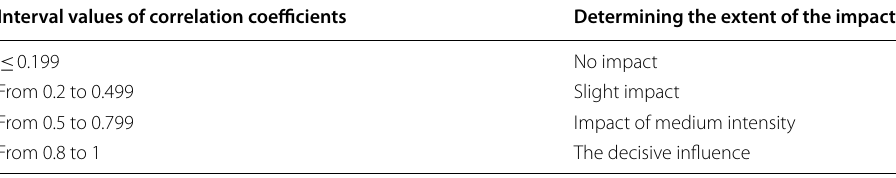
Table 1 Scale of correspondences of intervals of numerical values of the degree of